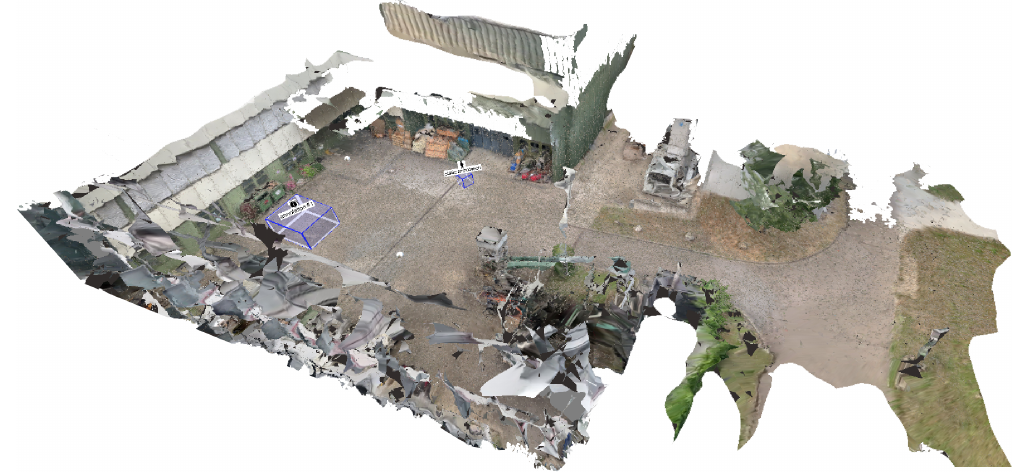
Figure 15. 3D scene that can be inspected by flying around in it, which interactively changes the perspective.